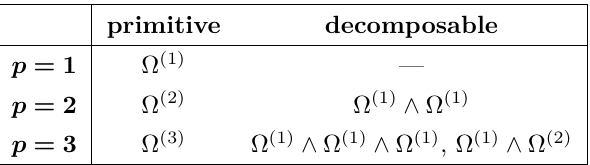
Table 2 . Schematic list of possibilities how to construct cohomology generators of a given degree. In general, the list of possible decomposable cohomology generators is determined by the partitions of the cohomology degree: degree- p cohomology includes all decomposable generators of the